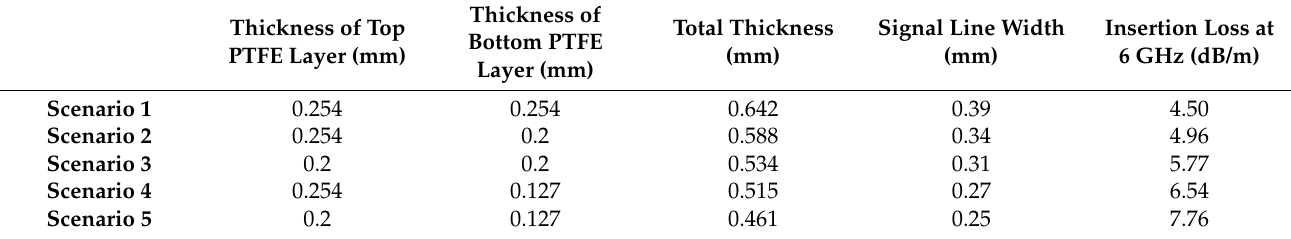
Table 3. Simulation scenarios of different PTFE